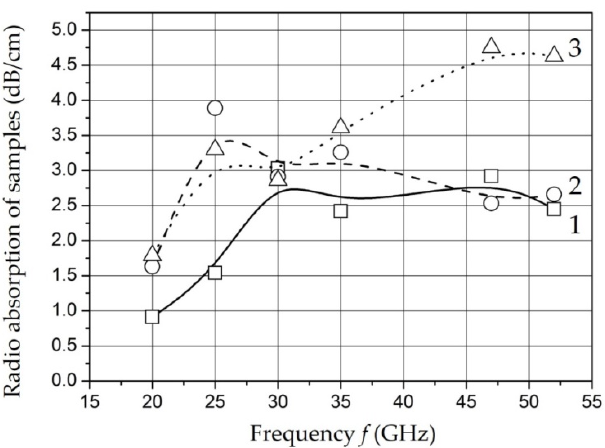
Figure 15. The dependence of the radio absorption of the samples Fe -01 (1), Fe -02 (2), and Fe -03 (3) on the operating frequency. Adapted from [129] with permission.